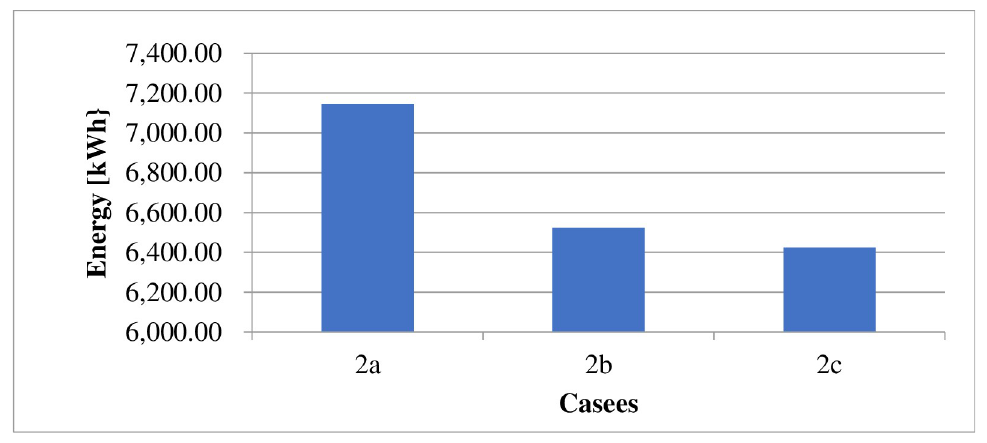
Fig 3. Energy losses per day–case 2.